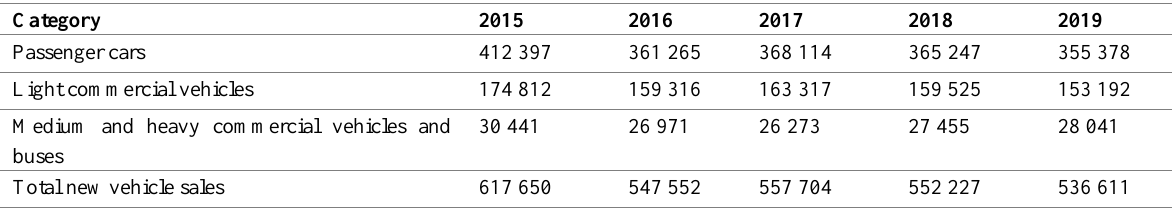
Table 1 : Sales of Passenger Cars and Commercial Vehicles (2015 – 2019)